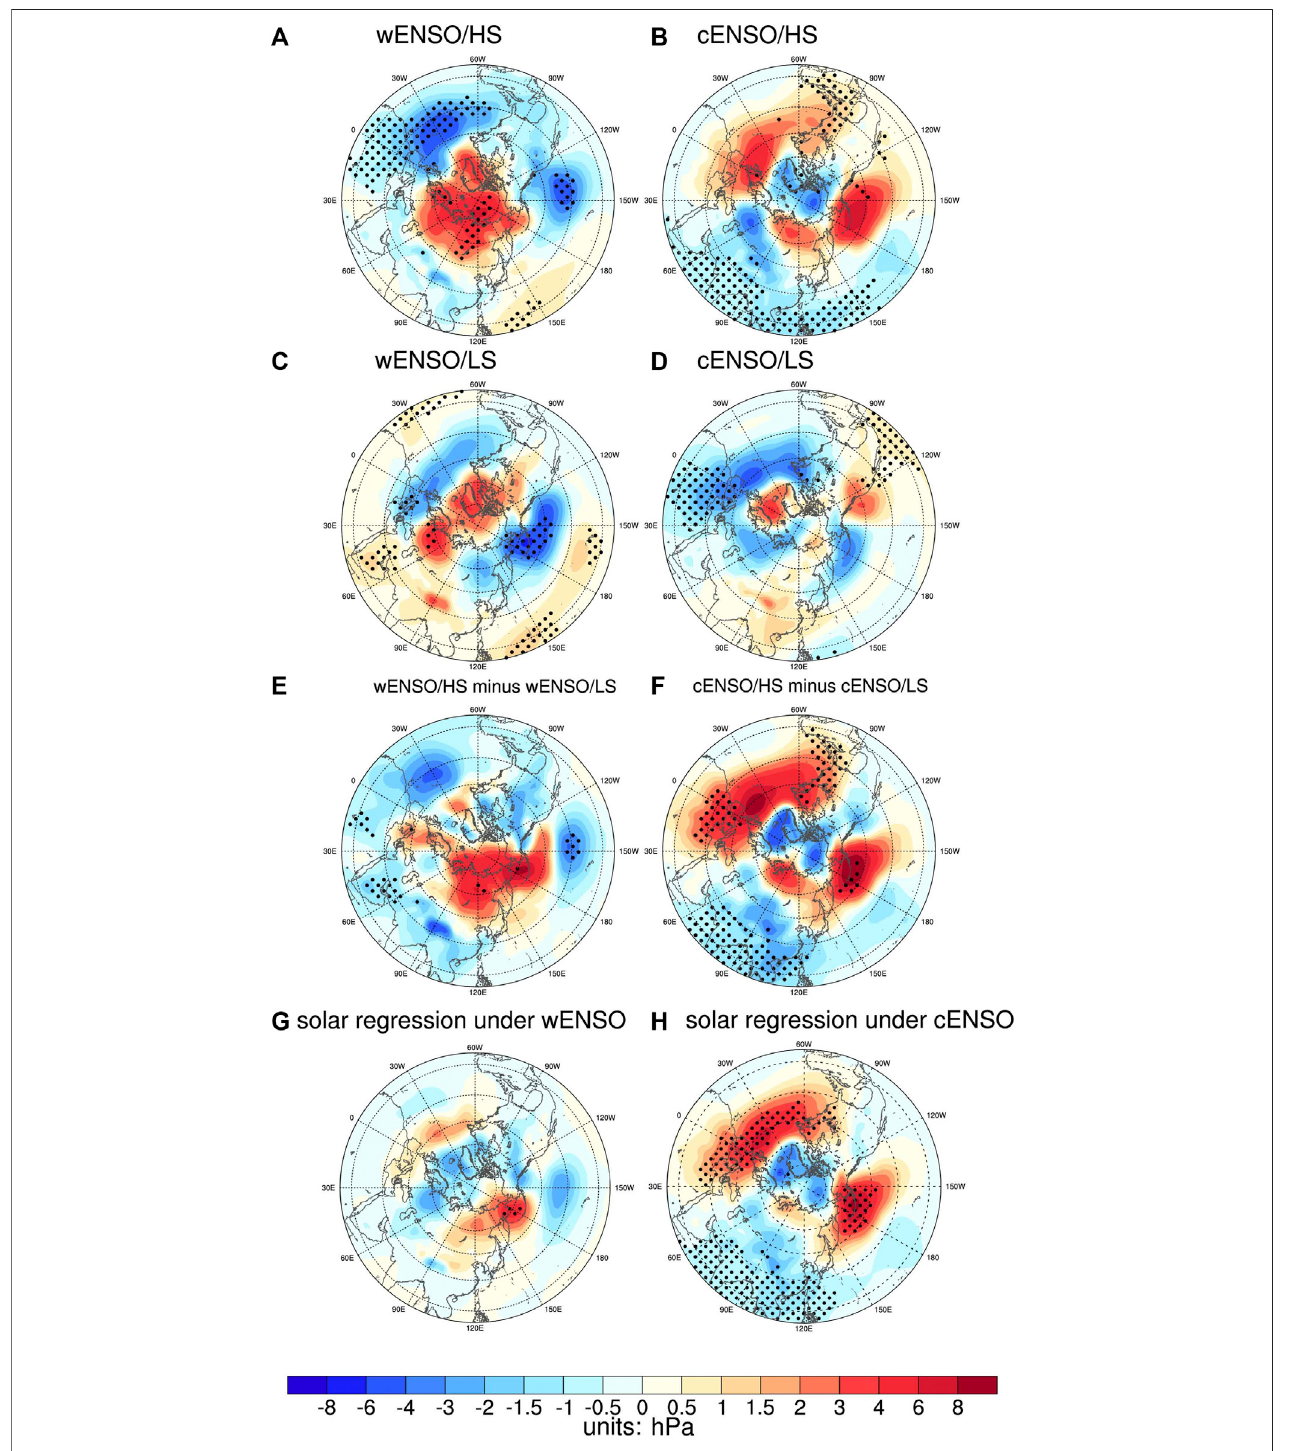
FIGURE 6 | panels (A – F) are similar as Figure 4 , but for composites of SLP anomaly (unit:hPa), panels (G) , (H) show regression of SLP onto SSN under wENSO andcENSOphase,respectively.Theregressioncoef fi cientsarescaledasbymultiplyingtwostandarddeviationoftheSSNindex,thustheunitsofthesesignalsarehPa. Solid dots denote 95% con fi dence